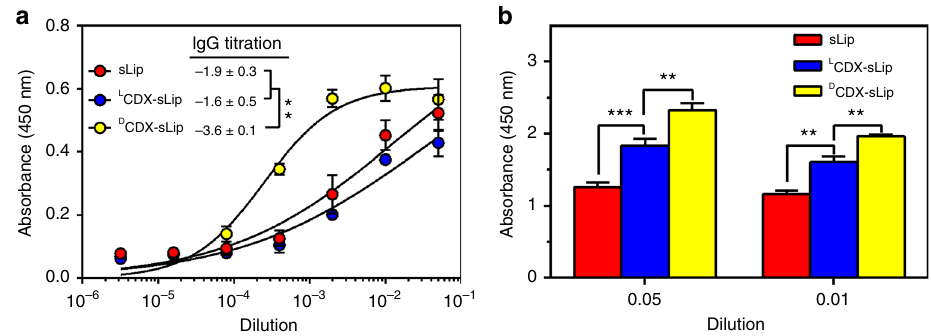
Fig. 1 Immunogenicity of liposomal formulations. a IgG titrations. Absorbance in the ELISA plate versus serum dilution and antibody titer reported as log (EC50). mPEG2000-DSPE, L CDX-PEG3400-DSPE, and D CDX-PEG3400-DSPE were used as antigens for sLip, L CDX-sLip, and D CDX-sLip, respectively. b Absorbance in the ELISA plate for anti-PEG IgM evaluation. mPEG2000-DSPE was used as antigen for all formulations. n = 3, data are means ± s.d. Statistical signi fi cances were calculated by Student ’ s t -test. ** p < 0.01, *** p < 0.001